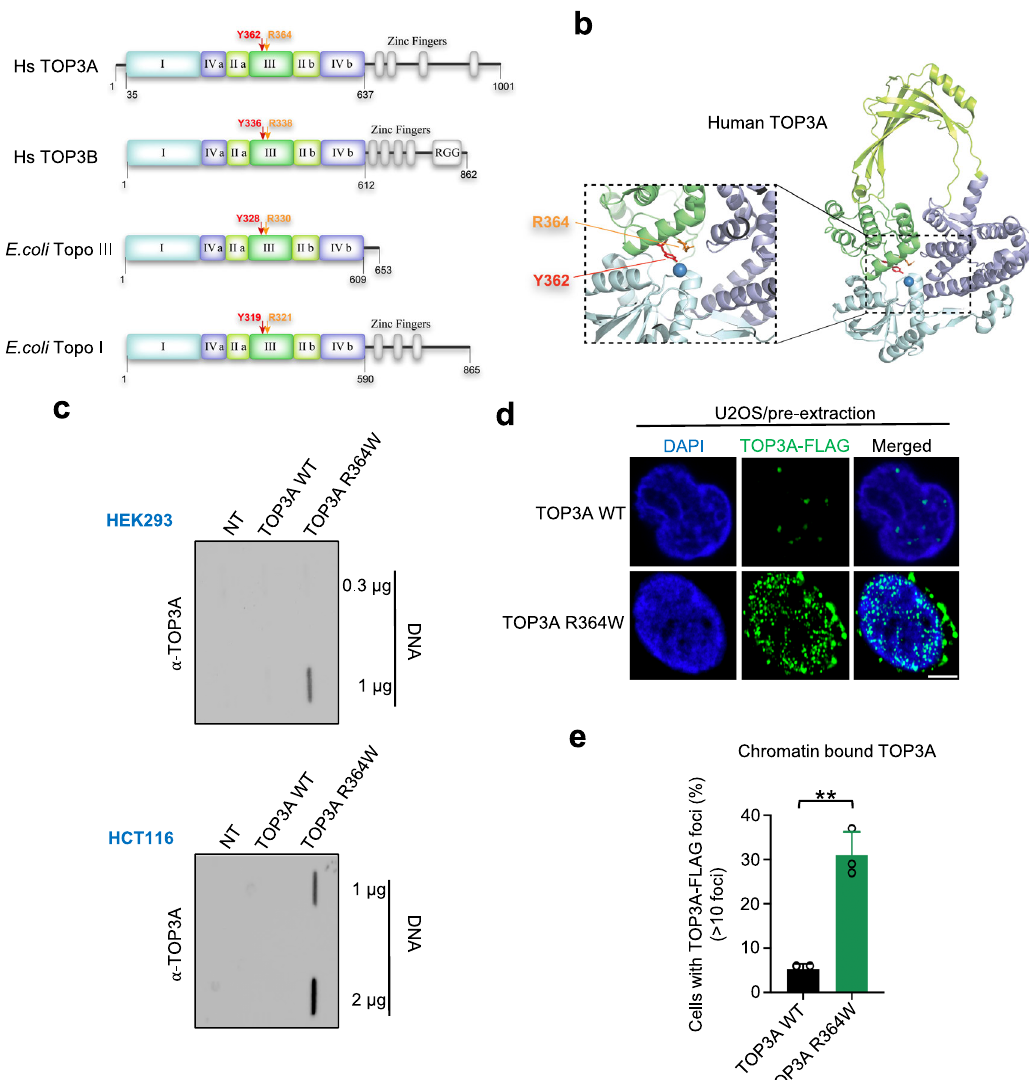
Fig. 1 | TOP3A forms TOP3Accs in cells transfected with R364W-TOP3A. a Domain organization alignment of human and bacterial type IA topoisomerases; TOP3A and TOP3B for human, Topo III, and Topo I for E. coli . The conserved catalytic tyrosine residues with their amino acid position are indicated by red arrows. Conserved arginine amino acid residues are indicated in orange. b Structure of human TOP3A and ribbon representation of human TOP3A (amino acid [aa] residues 1 – 637) 10 with the catalytic active site Y362 and the self-trapping mutation site R364. Zoom in on the part of structure where red and orange lines indicate the position of Y362 and R364. c Representative slot blot of TOP3Accs detected by RADAR assay in the indicated human cells transfected with the